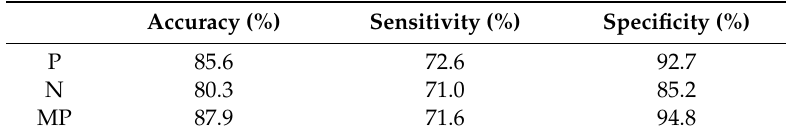
Table 1. Prediction performances of the developed